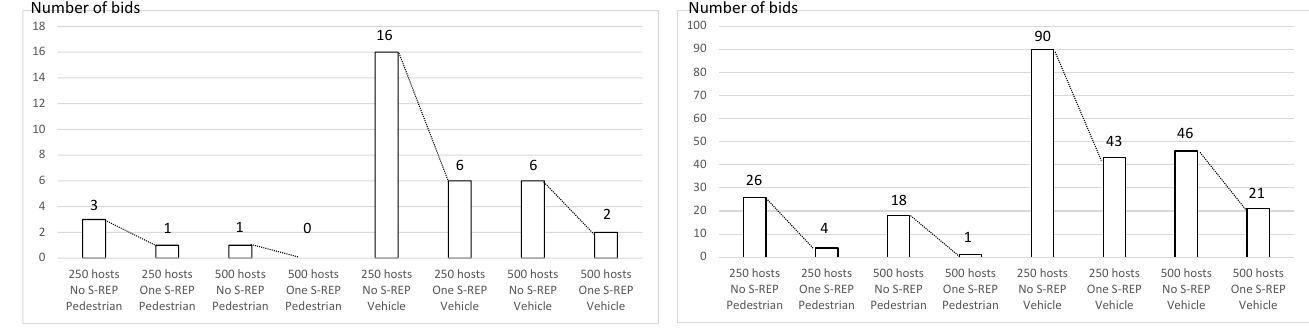
Figure 19. Number of different successful bids in cases with misbehaving hosts.